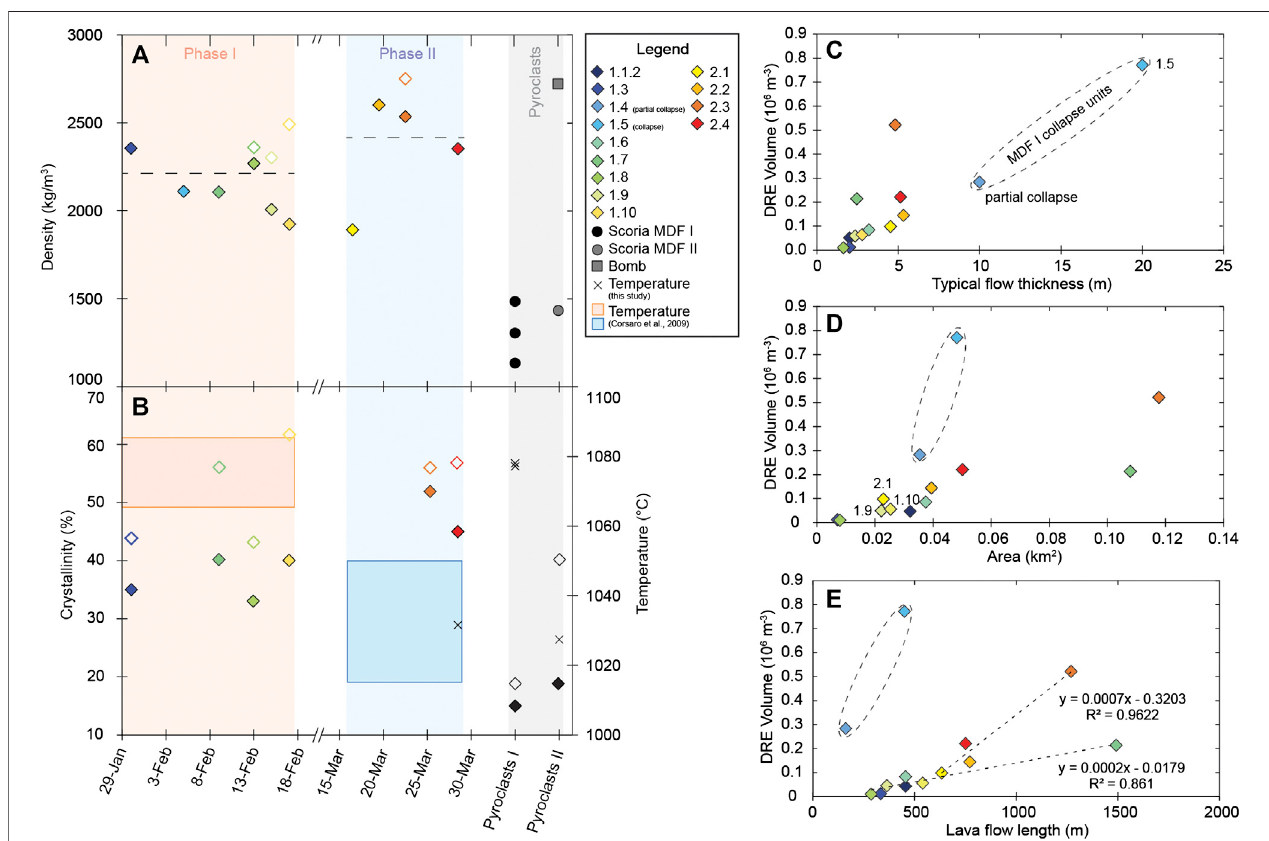
FIGURE6|(A) Densityand (B) crystallinityandgeothermometer-derivederuptiontemperatureforsamplesanalyzedduringeachphase.Eachlava fl owunitsample issequencedinchronological order. Scatter plotsofDRE volume vs. lava fl owunit (C) thickness, (D) area, and (E) length. Empty diamonds represent lavafront samples in (A) and vesicle-free crystallinity in (B)